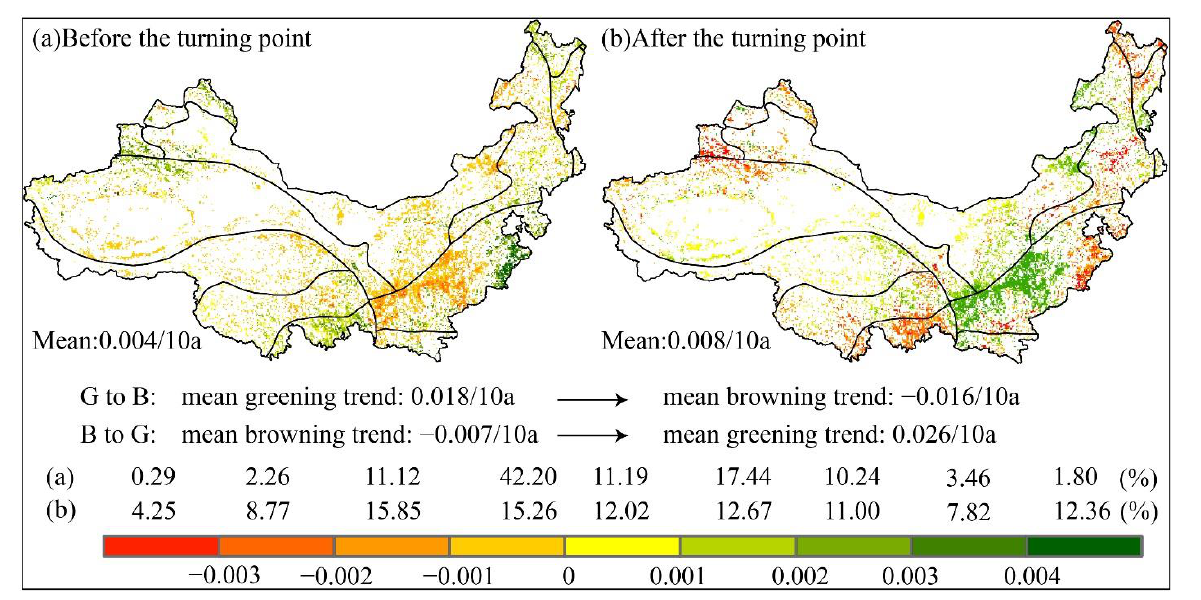
Figure 6. The average trend for EEMD before ( a ) and after ( b ) the turning point ( p < 0.05 ) . Table 4. The trend of vegetation GSN in different land cover types for EEMD (%). Land